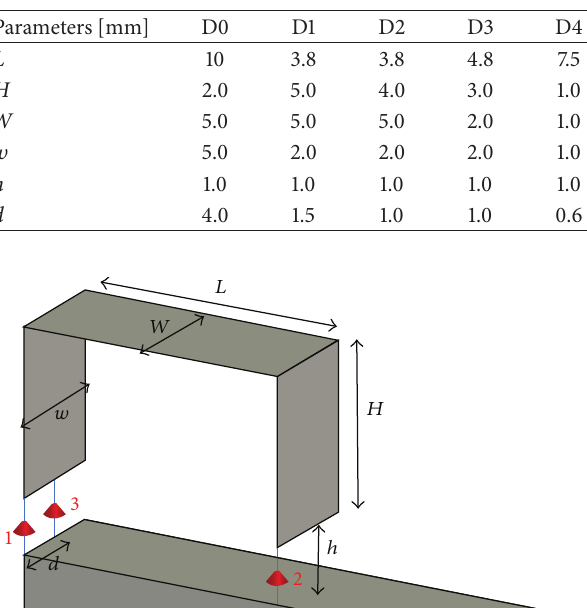
Table 2: Antenna geometry.